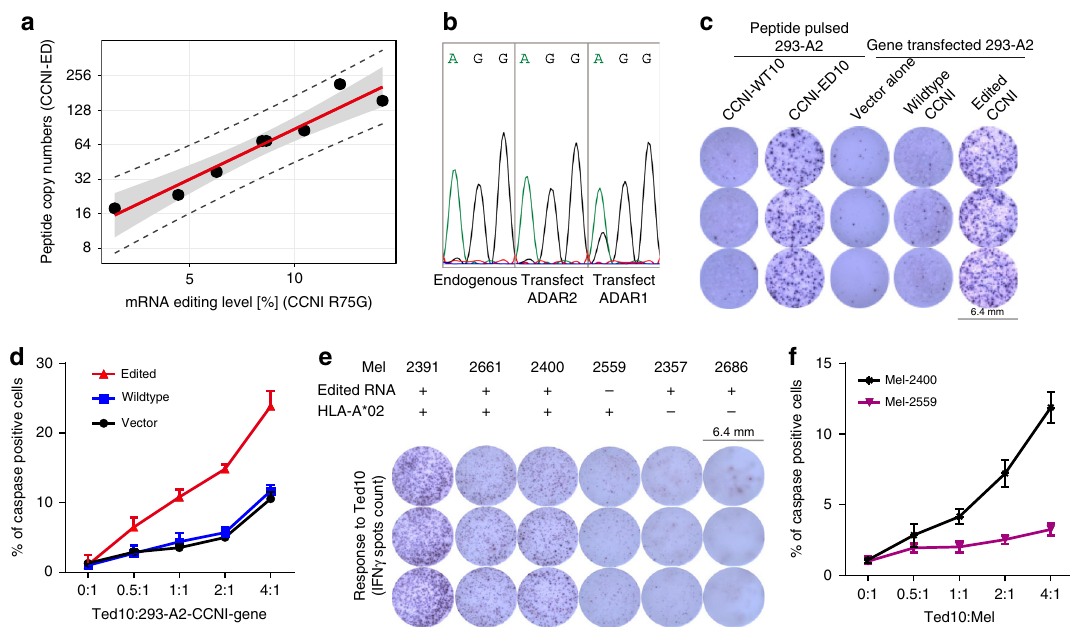
Fig. 3 Edited CCNI peptide level is correlated with its biological function. Correlation of CCNI peptide levels with CCNI and ADAR mRNA expression as well as Ted10 activation and Ted10 mediated tumour target killing. a Correlation between the number of edited CCNI peptide copies per cell determined by the AbsQuant ® method and mRNA editing levels determined by targeted RNA-seq for CCNI R75G . The scatterplot ( n = 8) includes the regression curve (red line) as well as the 95% con fi dence interval (grey band) and 95% prediction interval (dashed lines). b CCNI-R75G is edited by ADAR1 . HEK 293 stably expressing CCNI wildtype gene was transfected with empty vector or expression vectors of ADAR1 or ADAR2 . CCNI editing was measured by RT-PCR and followed by sequencing. The double peaks indicate nucleotide A to G conversion and the height of peaks re fl ect the level of editing. c ELISPOT assay showing IFN γ production by Ted10 incubated with peptide-pulsed or CCNI -transfected 293-A2 cells. d CTL killing assay showing that over-expression of edited CCNI gene increases the sensitivity of Ted10 mediated 293-A2 target killing ( n = 3), summarised as mean ± s.e.m. per titration. e IFN γ ELISPOT assay showing recognition of endogenous CCNI-ED antigen by Ted10. Mel-2391, mel-2400 and mel-2661 expressing both edited CCNI mRNA and HLA- A*02:01 are highly reactive to Ted10. Mel-2559, which was derived from the same patient as mel-2400 but does not have detectible edited CCNI mRNA, only reacted at background levels to Ted10. Mel-2357 and mel-2686, which express edited CCNI mRNA but do not express HLA-A*02:01, have no response to Ted10. f, Ted10 mediated target killing following incubation with mel-2400 and mel-2559 measured by caspase-3-based CTL killing assay (summarised as mean ± s.e.m. of the three